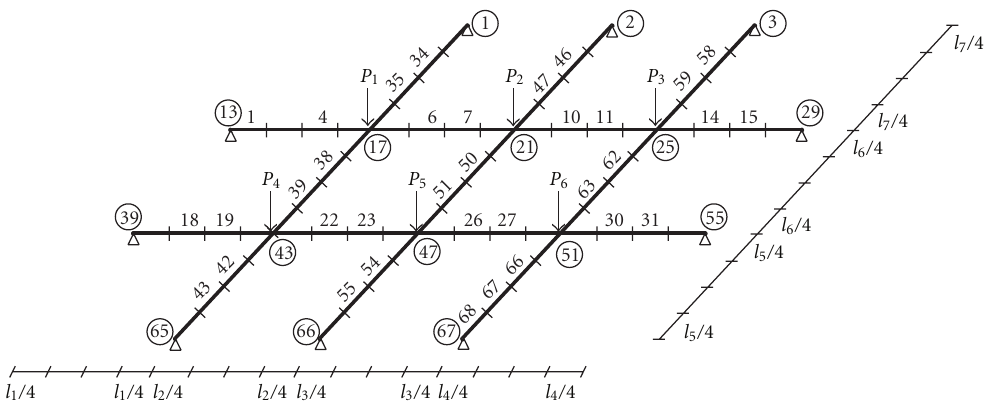
Figure 3: Geometry of 68-members grid structure including locations of point